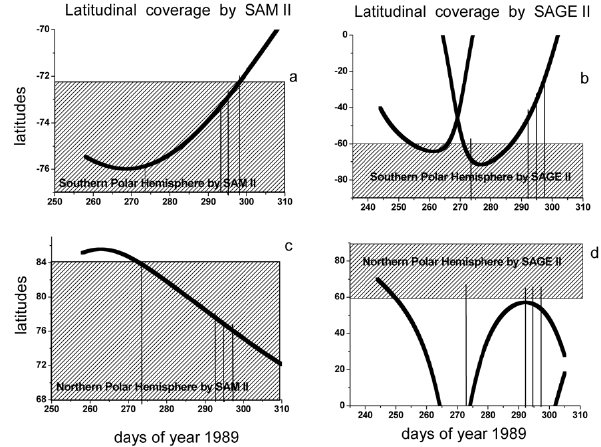
Fig. 2. Latitude distance of SAM II ( (a) and (c) ) and SAGE II ( (b) and (d) ) during September–October 1989. The days of GLEs marked by lines. (a) and (b) : latitudinal coverage of the satellites and operation of the instruments during each sunrise and sunset measurement over Southern Hemisphere. (c) and (d) : the same as for upper panel, but over Northern